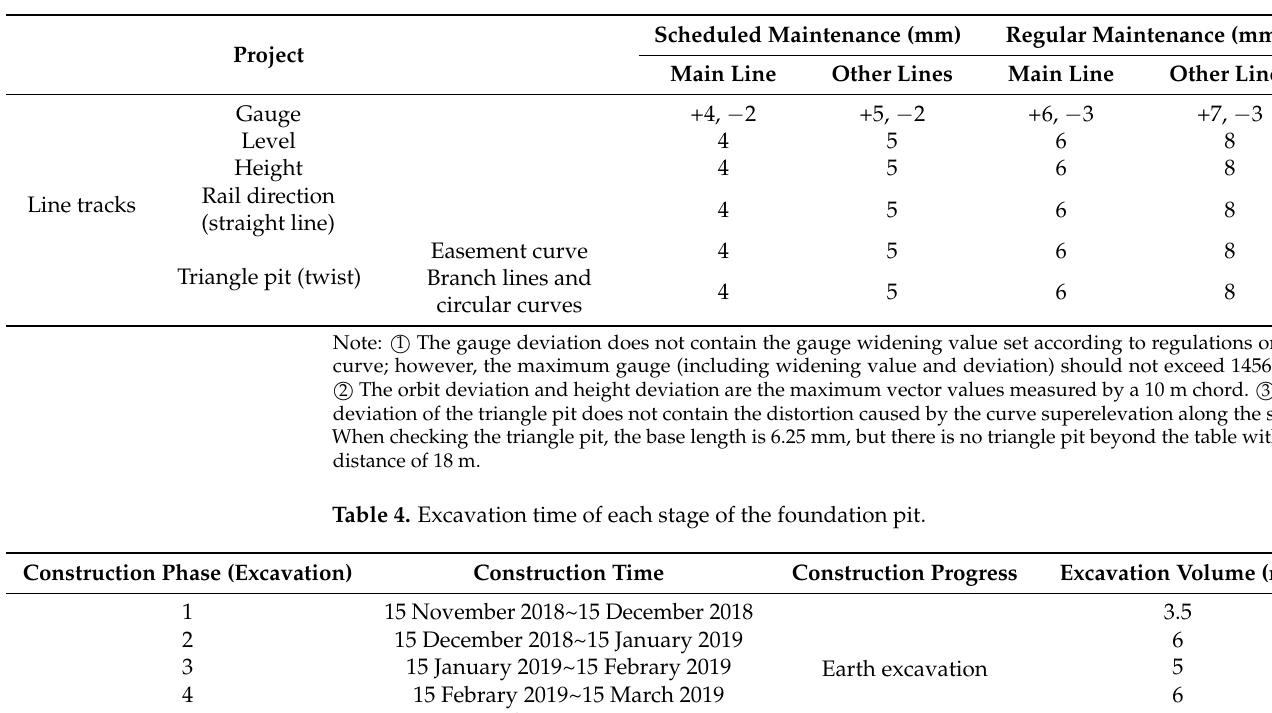
Table 3. The management values of the allowable deviation of the static geometric dimensions of the track.